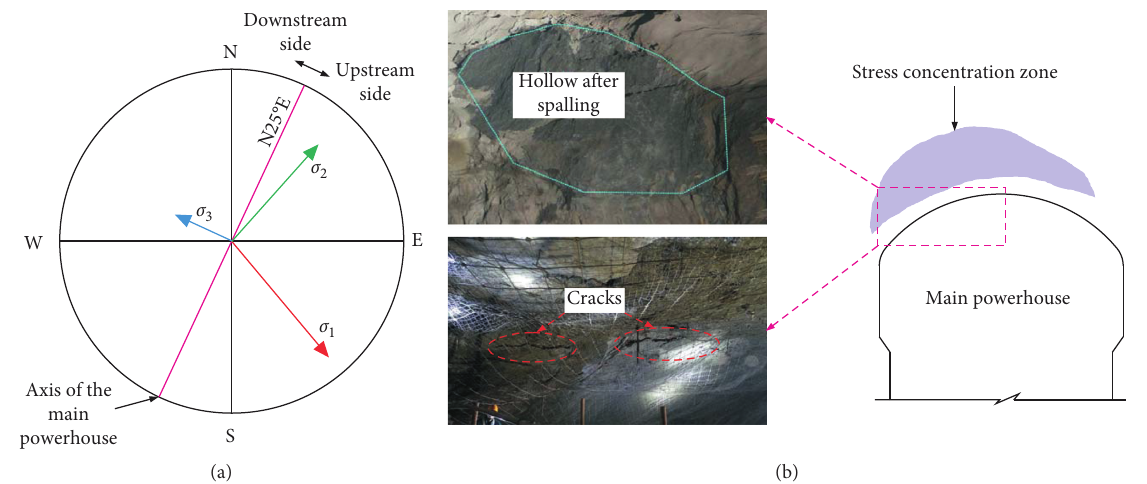
Figure 3: The stress-dominated failures in the Baihetan left bank underground powerhouse: (a) the correlation between the principal stresses and the powerhouse axis; (b) a hollow after spalling and shotcrete layer cracks at the upstream side of the